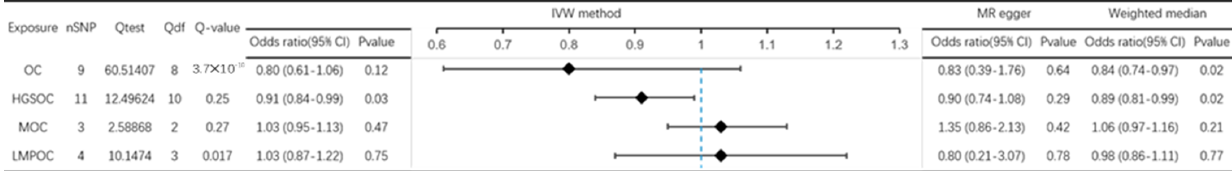
Figure 2. MR analysis results from OC to PD risk. IVW method, MR egger, and weighted median method estimate for the association of OC (including its common subtypes) with risk of PD.